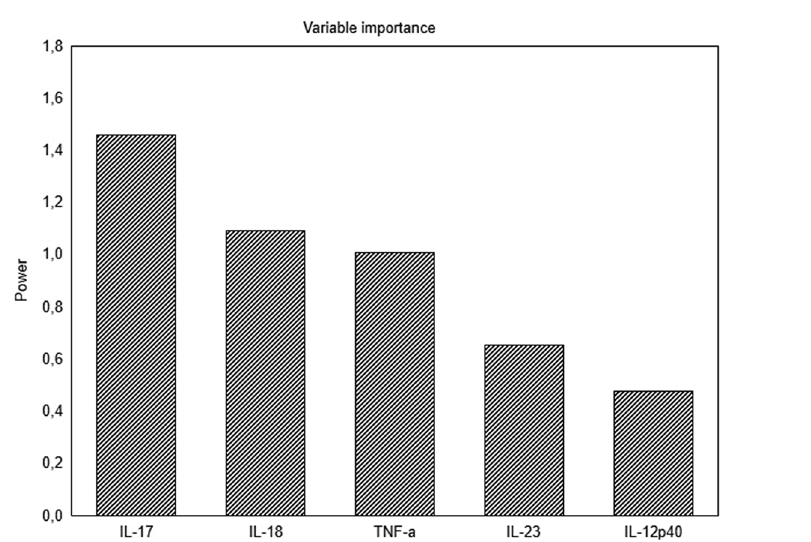
Figure 3. Bar graph shows which cytokines account the most for separation between groups according to PLS-DA analysis based on their VIP (Variable Importance in Projection)